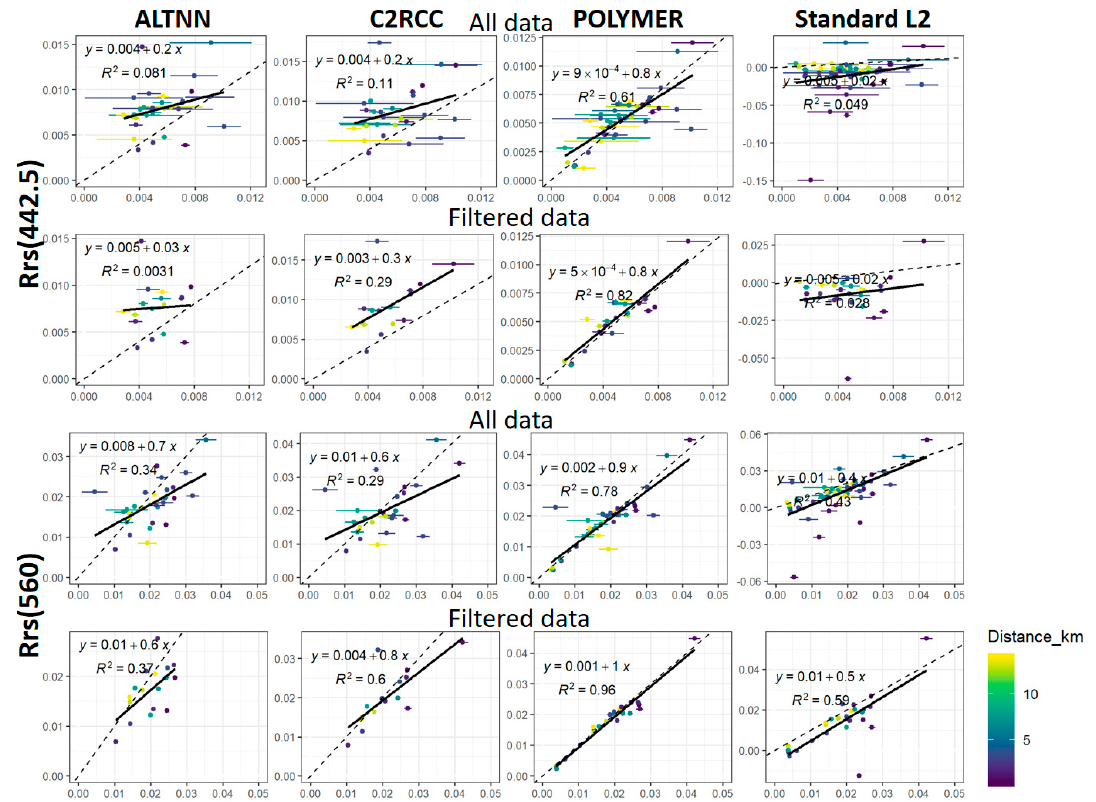
Figure 8. Correlation between in situ measured ( x -axis) vs. satellite-derived rho ( y -axis) on OLCI bands at 442.5 and 560 nm from C2RCC, ALTNN, POLYMER and standard AC. For both bands, upper row shows validation results on all data and lower after filtering the in situ data based on the 5% criteria at least in one band. For each match-up point, the color shows the distance from the shore.